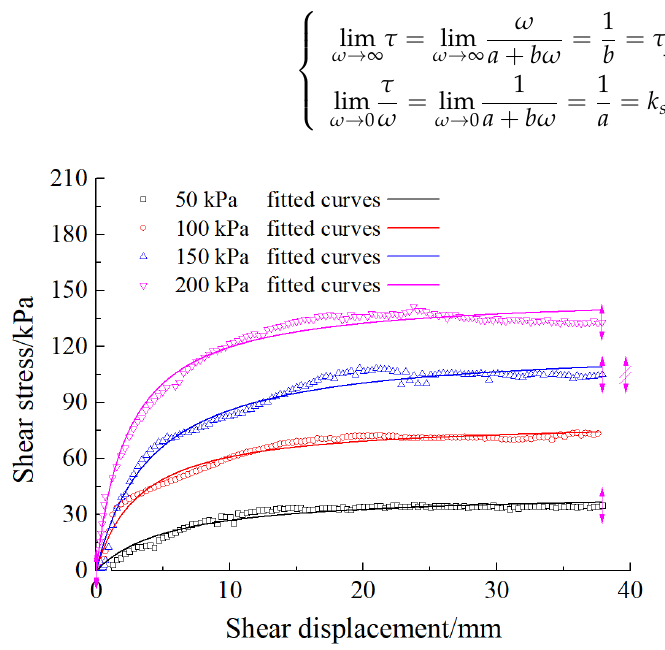
Figure 14. The comparison of the tested data points and fitted curves of shear stress and shear displacement between concrete plate corroded for 93 days and sand. Table 4. Direct interface shear experimental results and fitted parameters of the experimental data.